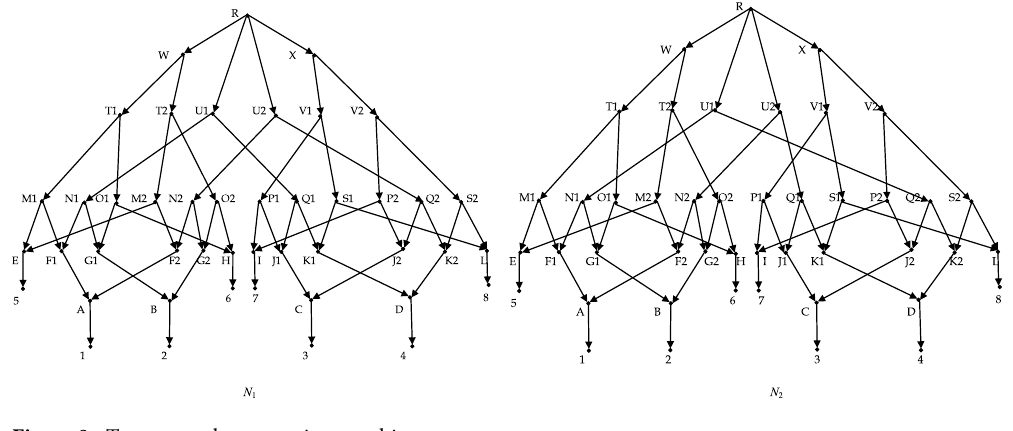
Figure 9. Two networks are not